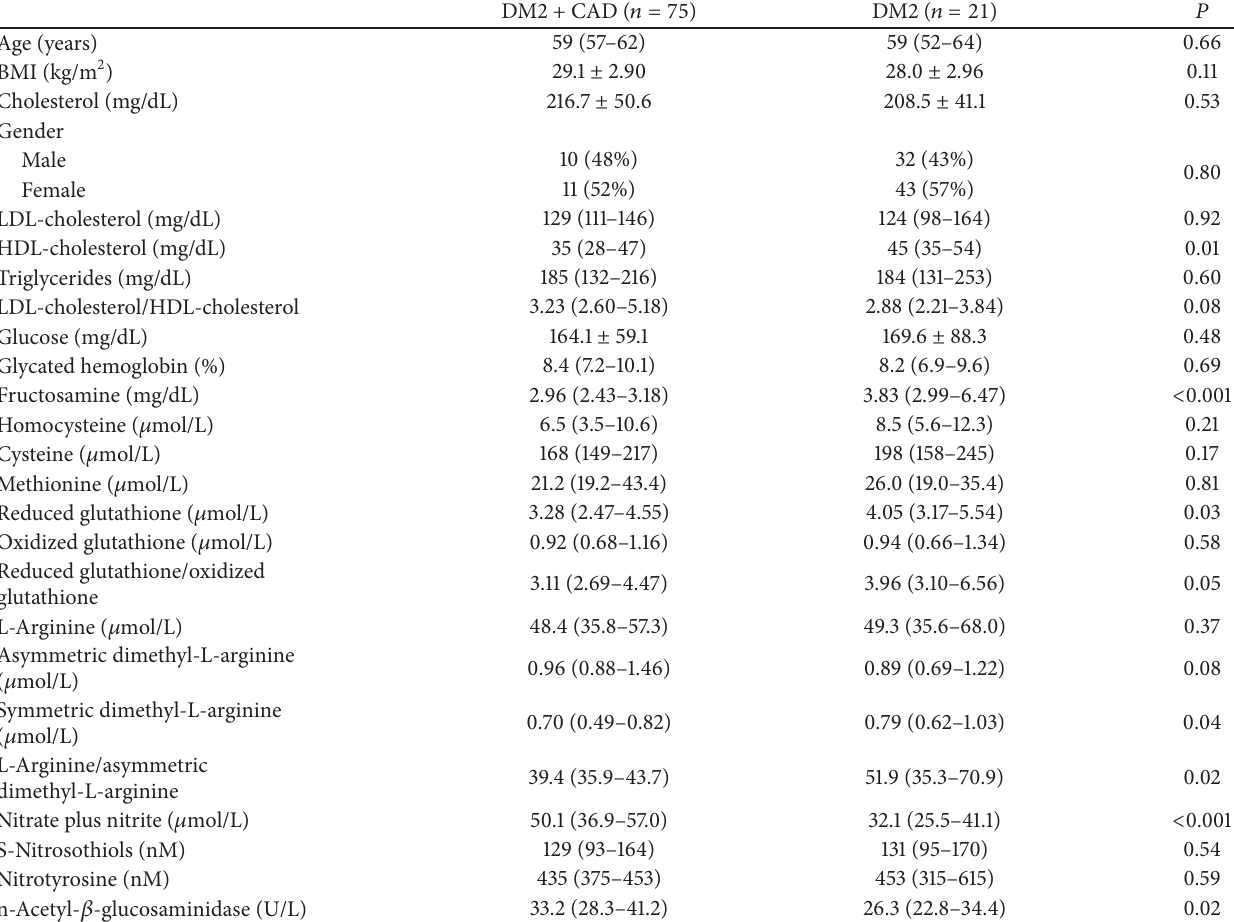
Table 1: The demographical clinical and biochemical characteristics of the 96